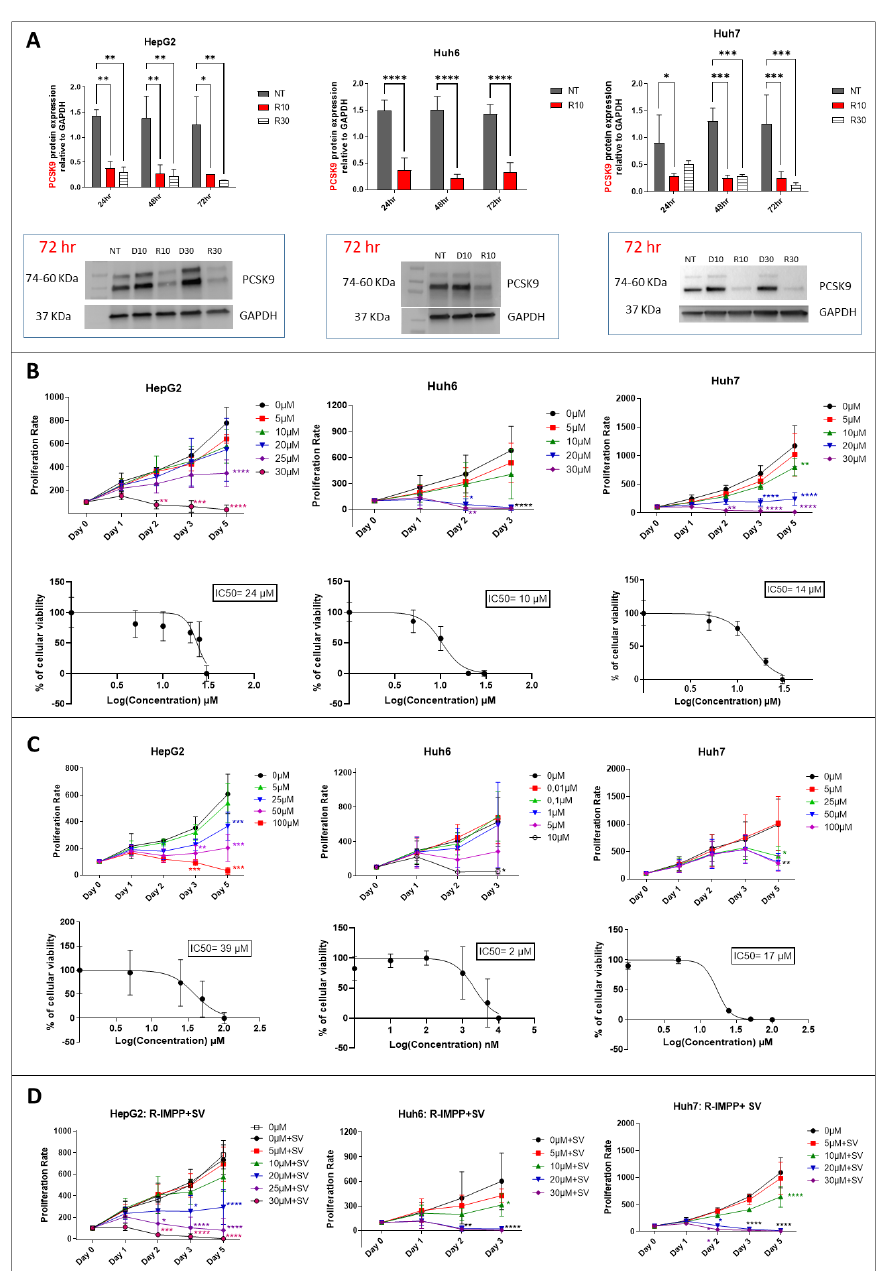
Figure 2. Effect of pharmacological inhibition of PCSK9 and HMGCR on cellular proliferation. ( A ) Inhibition of PCSK9 protein level by R-IMPP. Huh7 and HepG2 cells were treated with 10 and 30 µ M of R-IMPP, whilst Huh6 cells were treated with 10 µ M of R-IMPP. PCSK9 protein level was evaluated by Western blot in these 2 conditions 24, 48 and 72 h after treatment. Internal GAPDH was used for protein normalization (n = 3). NT: non-treated; D: DMSO; R: R-IMPP. ( B ) Dose-dependent inhibition of cell growth by R-IMPP as evaluated by MTS analyses. IC 50 at day 3 is given for each cell line. ( C ) Proliferation was evaluated up to 5 days after SV treatment except for Huh6 where the experiment was stopped at day 3 because of the extensive cell death at this time point. IC 50 at day 3 is given for each cell. ( D ) Effect of R-IMPP treatment in combination with SV. The concentrations of SV were selected close to the IC 50 data from ( C ) (25 µ M SV for Huh7 and HepG2 and 5 µ M for Huh6). * Two-way ANOVA test. * p < 0.05; ** p < 0.01; *** p < 0.001; **** p < 0.0001. Supplementary Materials: original-images of western blot